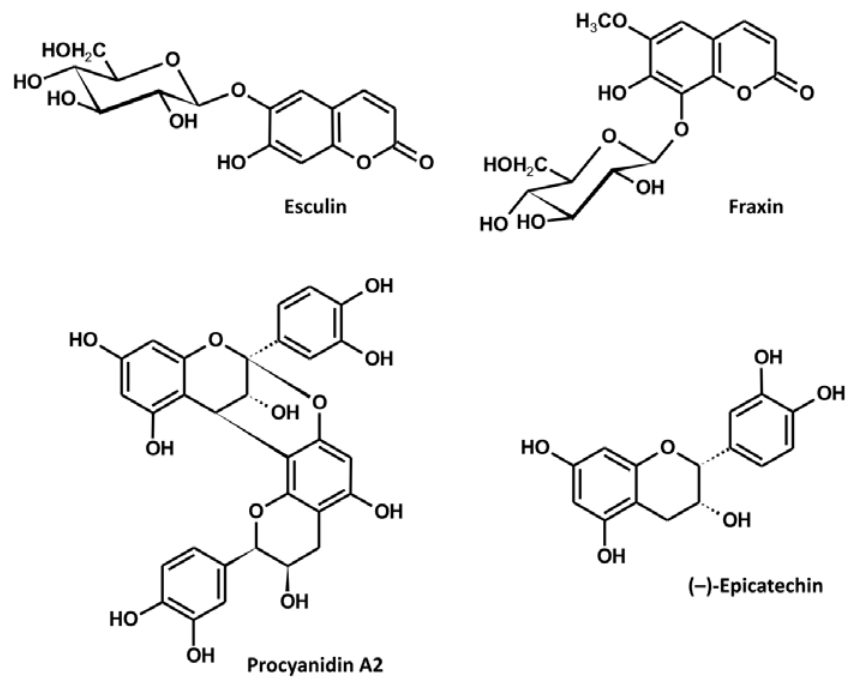
Figure 1. Structures of the major constituents of the A. hippocastanum bark.